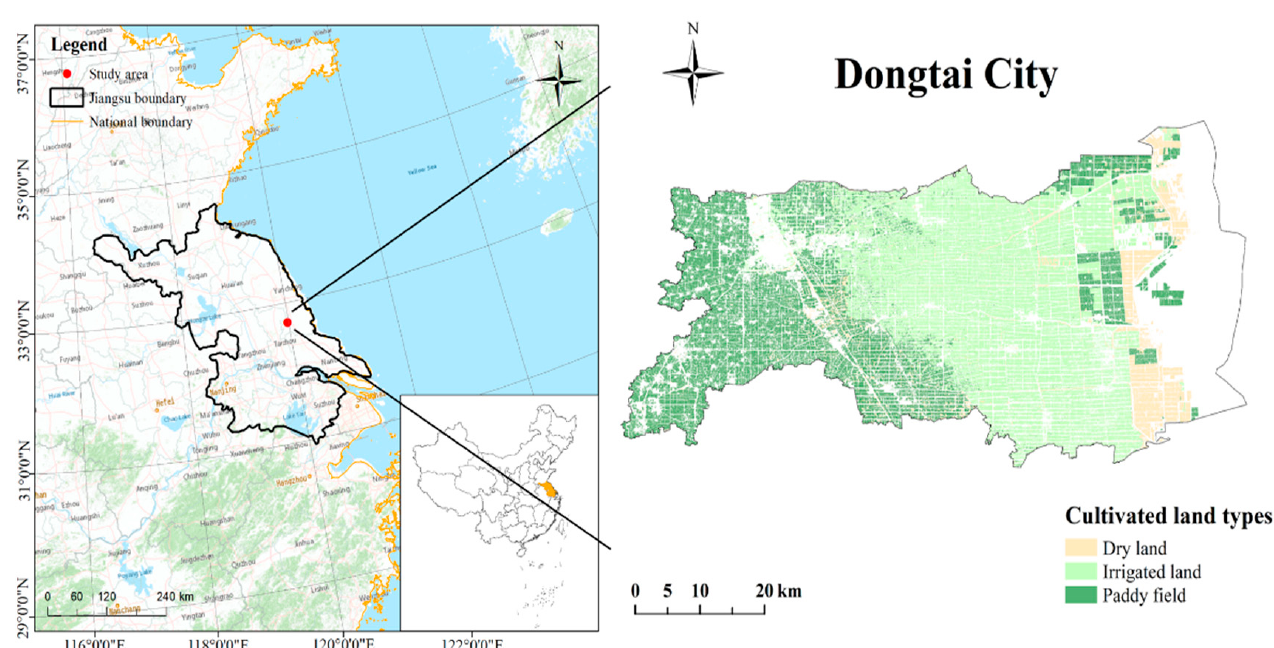
Figure 1. Map showing the location of the study area.